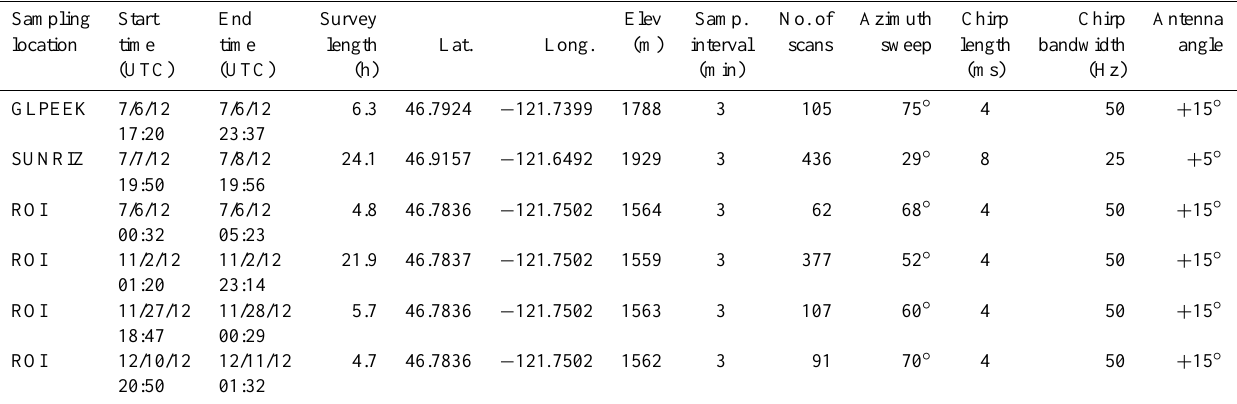
Table 1. Survey parameters.